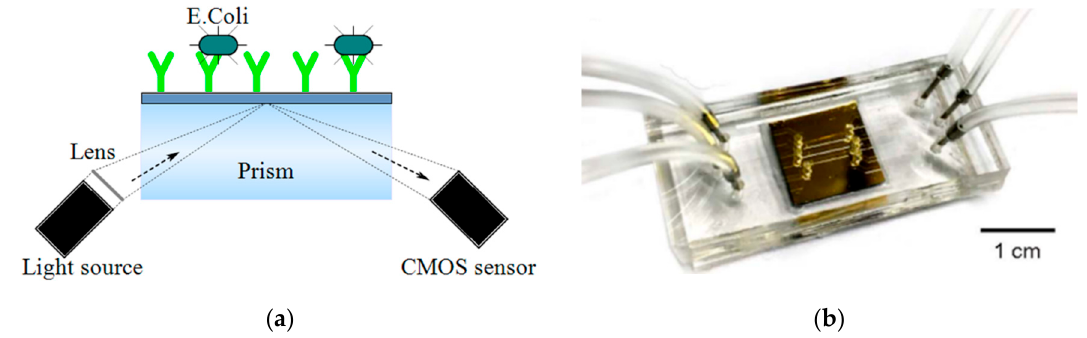
Figure 8. ( a ) Schematic of an SPR platform using a prism, ( b ) The gold plasmonic chip assembled with the PDMS microfluidics reported in [63] .